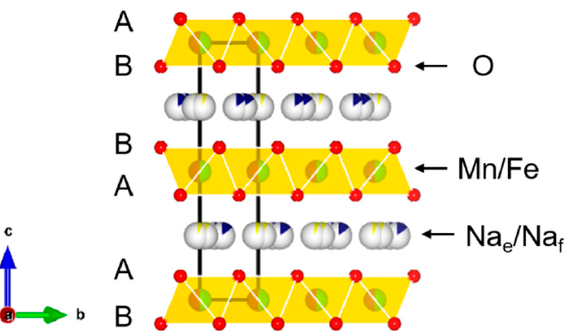
Figure 1. Crystal structure of P2-type Na 0.67 Fe 0.5 Mn 0.5 O 2 cathode with a typical hexagonal layered lattice of space group P63/mmc symmetry, having Na occupancy with Na e (edge share) and Na f (face share) amalgamated with yellow and navy-blue colors, respectively. Oxygen atoms are represented in red, Mn atom in orange and Fe atom in black.